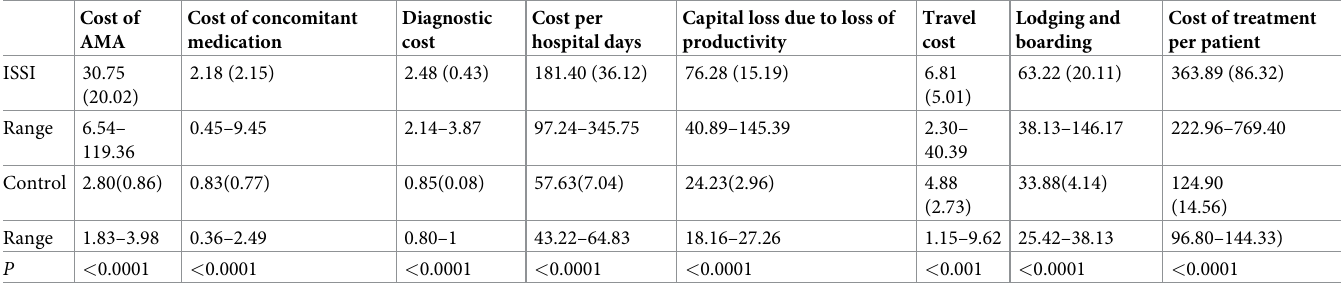
Table 2. Cost of treatment (in USD) in control and cases with post cesarean ISSI.